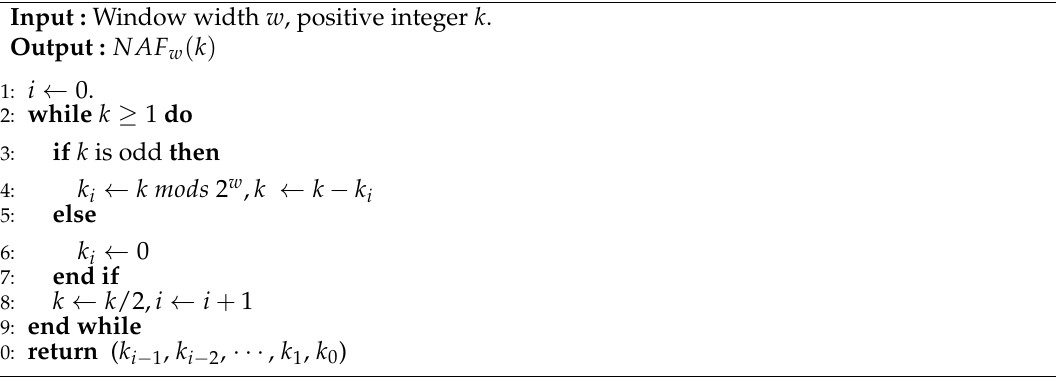
Algorithm 6 Window NAF method for point